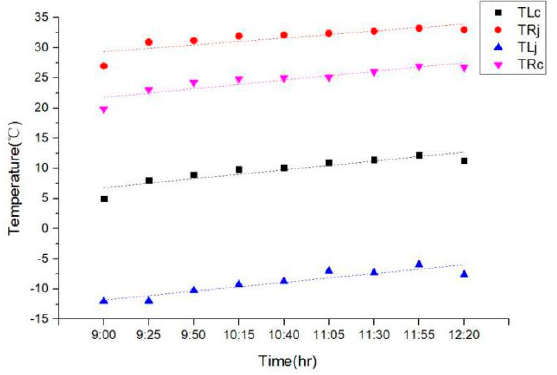
Figure 4. Indoor temperature and time changes on Jan.17 (TLc-fresh air outlet temperature; TRj-flue gas inlet temperature; TLj-fresh air inlet temperature; TRc-flue gas outlet temperature).